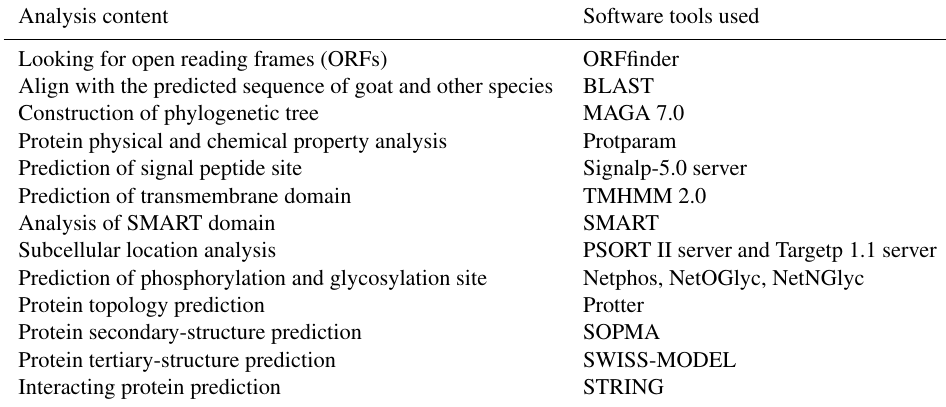
Table 2. Sequence analysis content and corresponding analysis tools. Analysis content Software tools